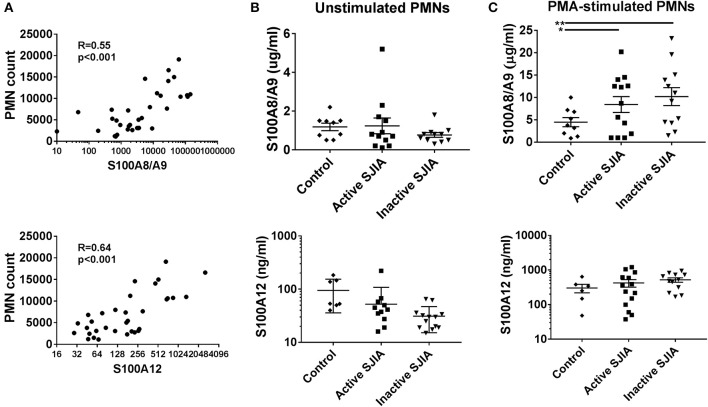
S100 alarmin proteins release by neutrophils in SJIA. (A) Correlation between circulating neutrophil count and serum S100A8/A9 (top) and S100A12 (bottom) in patients with SJIA. (B,C) S100 alarmin protein release from cultured neutrophils either at rest (B) or after PMA stimulation (C). Top panels represent S100A8/A9, bottom panels S100A12. Error bars represent mean ± SEM. *p < 0.05, **P < 0.01.